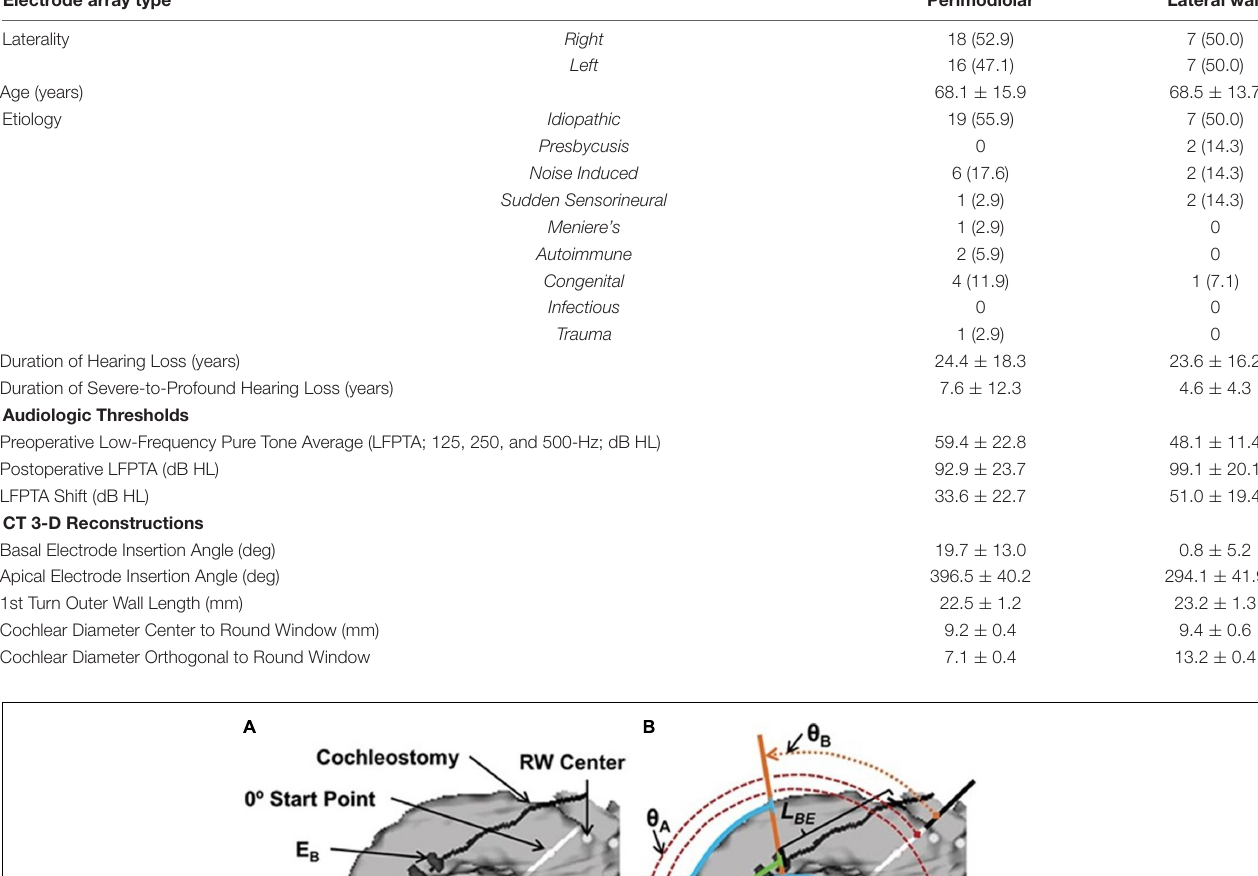
TABLE 1 | Demographic, audiologic, and 3-D CT reconstruction data for all 48 patients who met inclusion criteria and underwent cochlear implantation with multifrequency ECochG (250- and 500-Hz acoustic stimulus). Electrode array